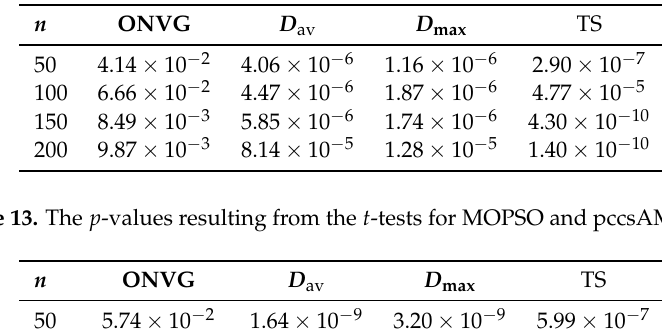
Table 12. The p -values resulting from the t -tests for MOPSO and MOEA/D-ACO.